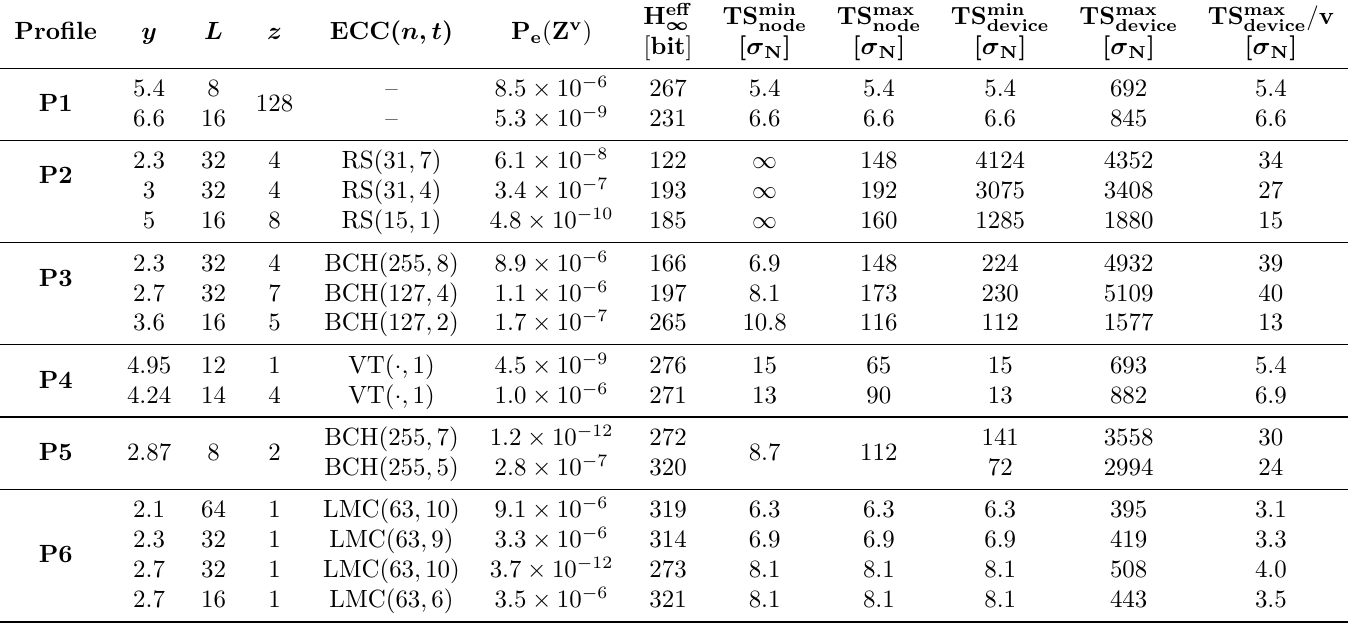
Table 2: Extended comparison of TS of different profiles for higher-order alphabet PUFs, including min -TS results and max -TS results normalized by the number of nodes v = 128 in the tamper-evident PUF